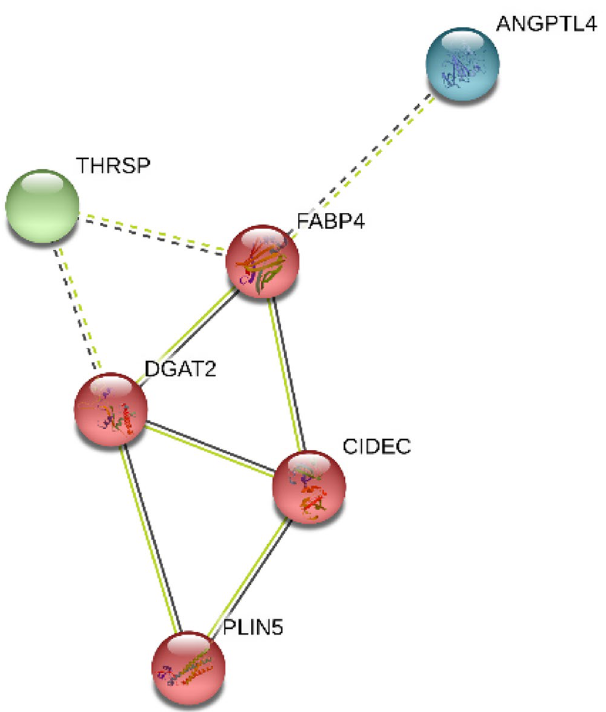
Figure 4. Overall expression data of interacting genes in the